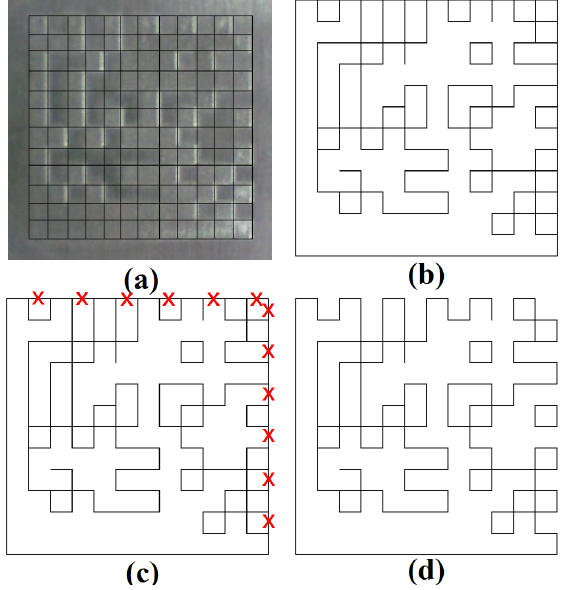
Figure 10. An edge image generation process: ( a ) a barcode image; ( b ) the edge image with solid line border; ( c ) modify the outermost border of the grid; ( d ) the modified edge